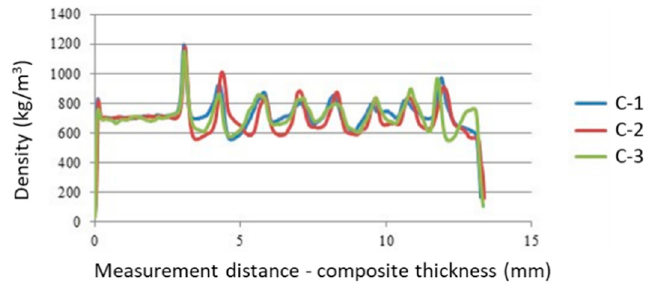
Figure 3. Density profile of 3 samples of quality C (C-1, C-2, C-3—number of the sample) after air conditioning under conditions of 22 °C and 50% air humidity.